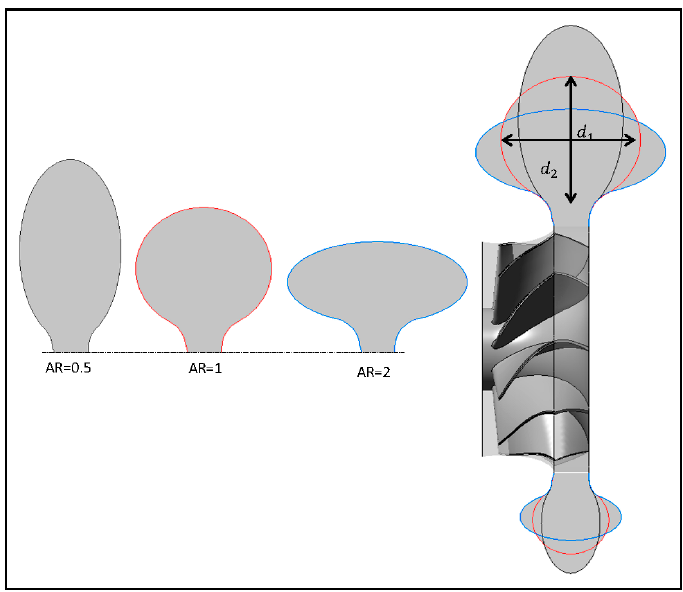
Figure 3. Aspect ratio designs: AR = 0.5, AR = 1 and AR = 2.